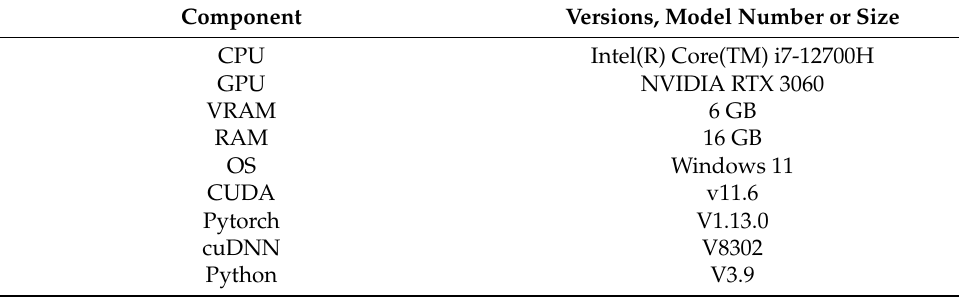
Table 1. The computational resources required for the experiment.